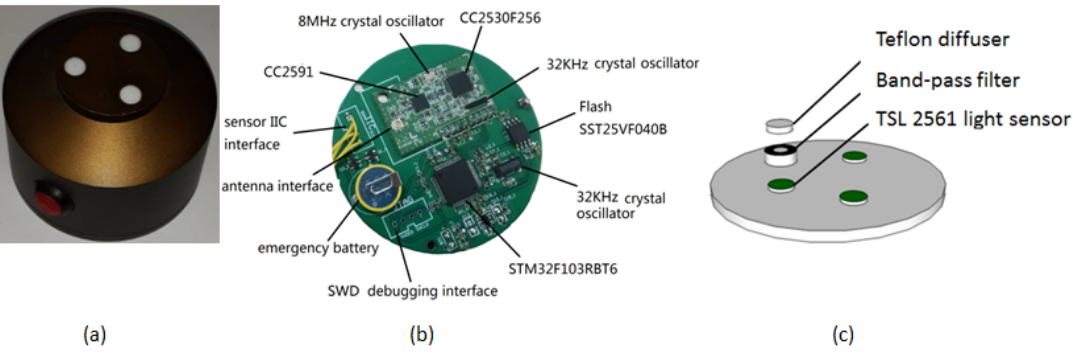
Figure 2. Hardware of a Above Node (AN) and its internal components. ( a ) Picture of a real AN; ( b ) Circuit board of AN; ( c ) Diagram of the optical sensor